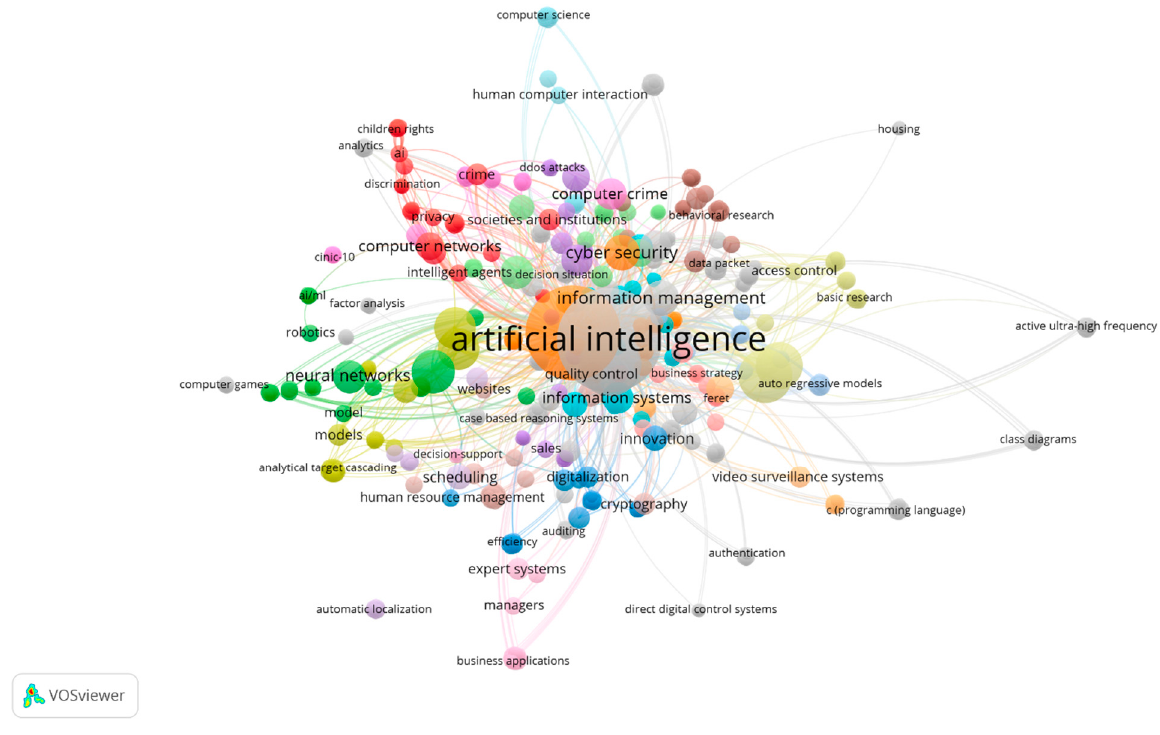
Figure 1. Subthemes/network of all keywords of AI—source: own elaboration.